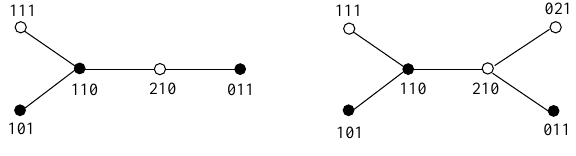
Figure 1: ID-colorings of two double stars.